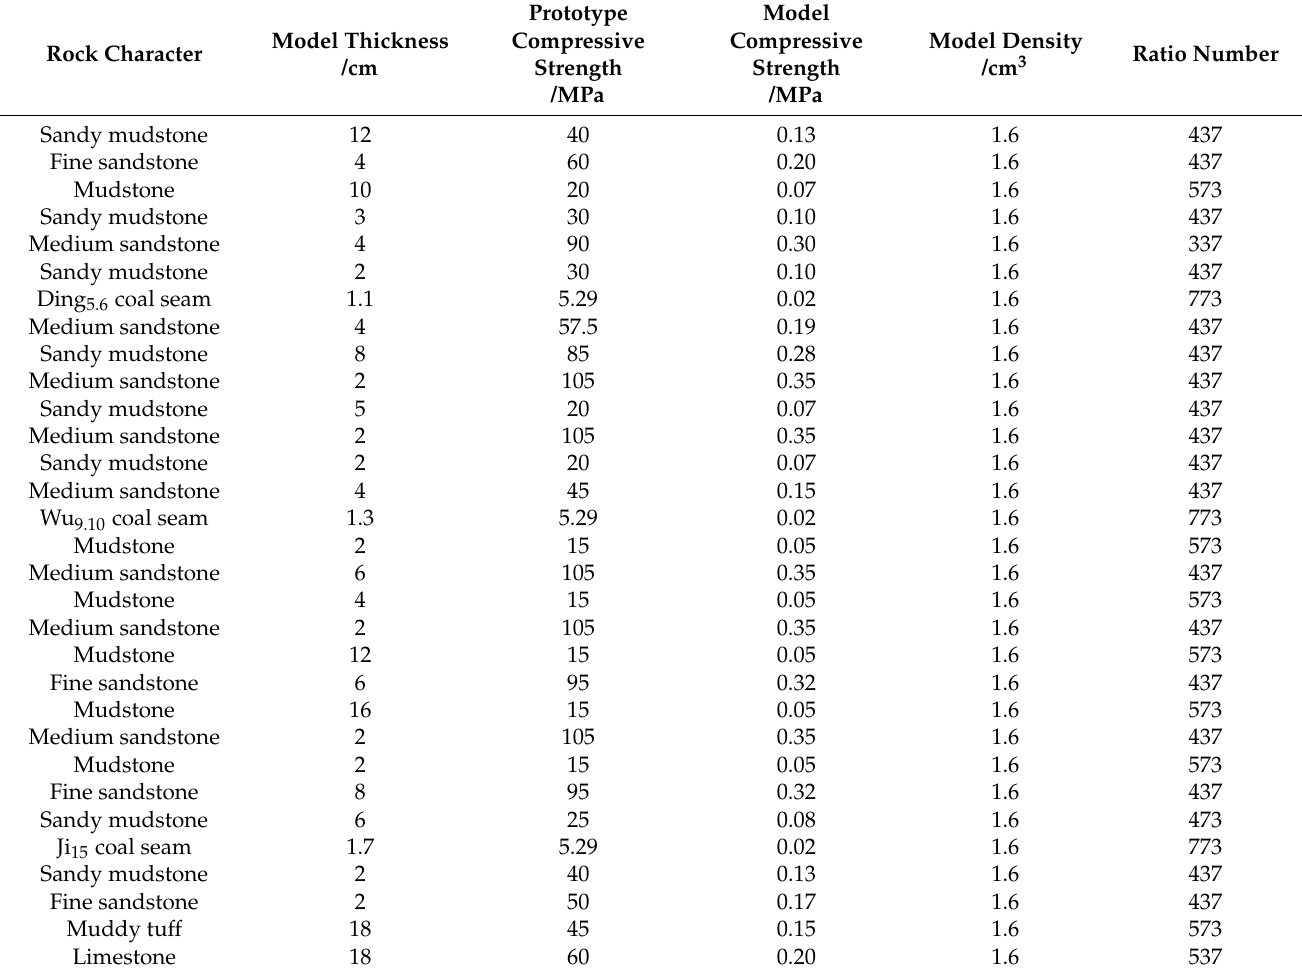
Table 2. Mechanical parameter of protolith and